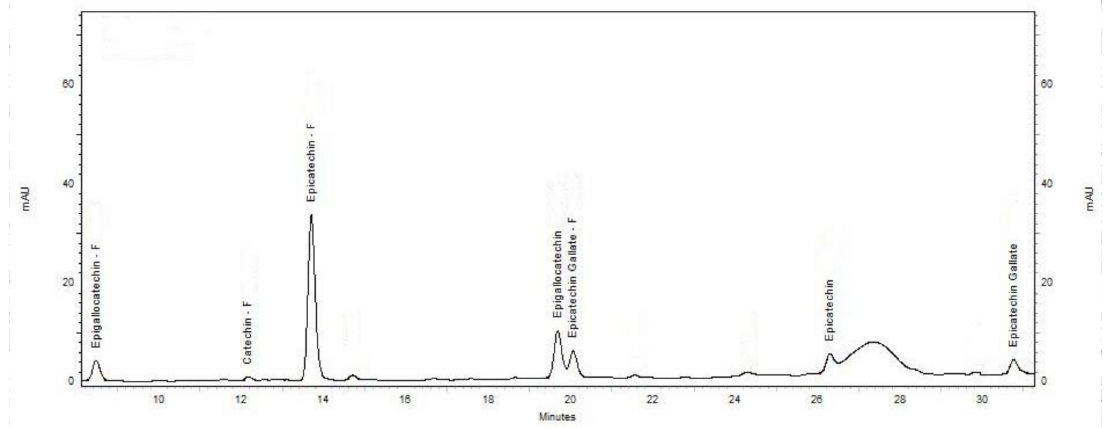
Figure 1. The chromatograms of HPLC